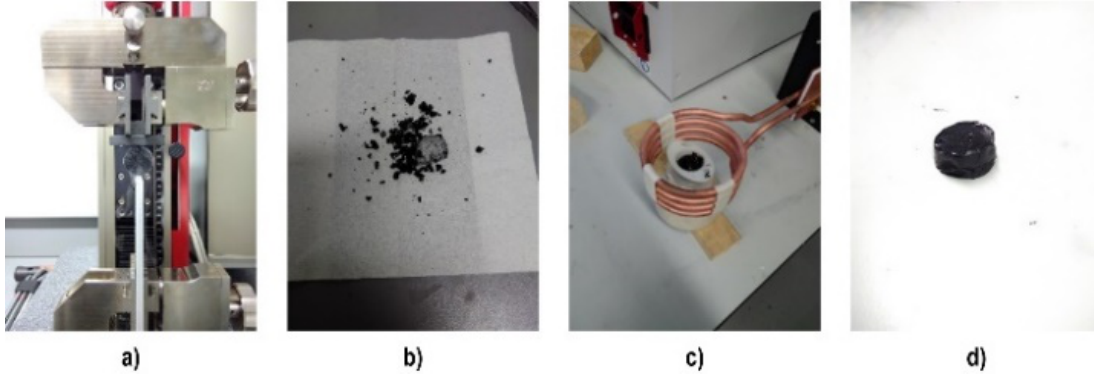
Figure 21. Capsule (mortar mix test specimen containing 10% capsule by weight) conductivity testing; ( a ) bitumen mix indirect tensile loading, ( b ) disintegrated test specimen, ( c ) induction heating/healing (5 min), and ( d ) restored test speci- men.